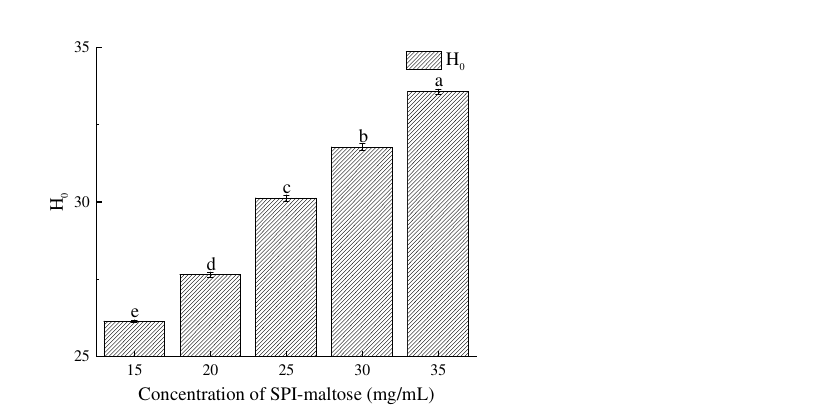
Figure 4. TSI of Pickering emulsions made by different oil phase volume fractions and different concentrations of SPI and maltose. (( A 0 ) prepared the initial emulsion with different concentrations of SPI and maltose, ( B 0 ) prepared the initial emulsion with different oil phase volume fractions, ( A 3 ) was the emulsion after three freeze-thaw cycles with different concentrations of SPI and maltose, ( B 3 ) was the emulsion after three freeze-thaw cycles with different oil phase volume fractions.) Firstly, the slope of the TSI curve of the Pickering emulsion after freeze–thaw cycle was higher than that of the initial emulsion, indicating that freezing would damage the Pickering emulsion and reduce its stability. This is because when the Pickering emulsion was frozen, oil phase or water phase in the Pickering emulsion crystallized to make the droplets gather, which destroyed the film at the oil–water interface of the Pickering emul- sion, making the Pickering emulsion easier to agglomerate during the dissolution process, and thus reducing its stability [21]. By increasing the concentration of SPI and maltose,